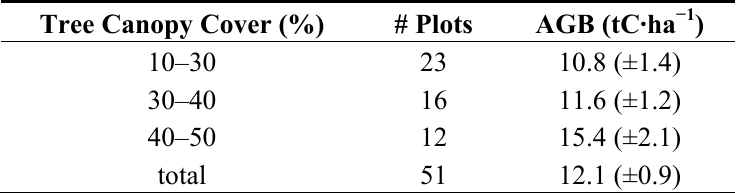
Table 1. Average above-ground biomass (AGB) (tC·ha − 1 ) values per tree canopy cover class (standard error of the mean in parentheses). A factor of 0.47 was used to convert from biomass to C content